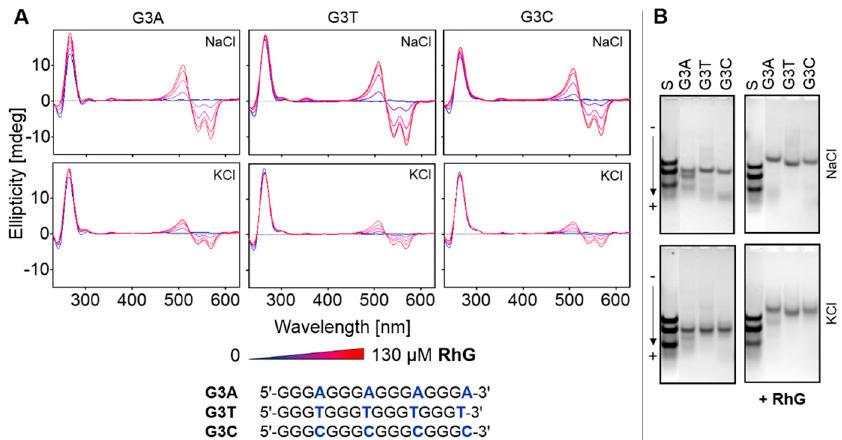
Figure 5. CD titration spectral measurements and PAGE of d(G 3 NG 3 )G 3 sequences (~27 µ M) at different ionic conditions in the presence of increasing concentrations of RhG up to 260 µ M ( A ). The increment of RhG is ~33 µ M. The left and right PAGE panels ( B ) represent electrophoretic records in the absence and presence of 130 µM of ligand, respectively. Electrophoresis was performed in the presence of both 50 mM NaCl and KCl. The mixture of AC9, AC18 and AC28 is used as standard.